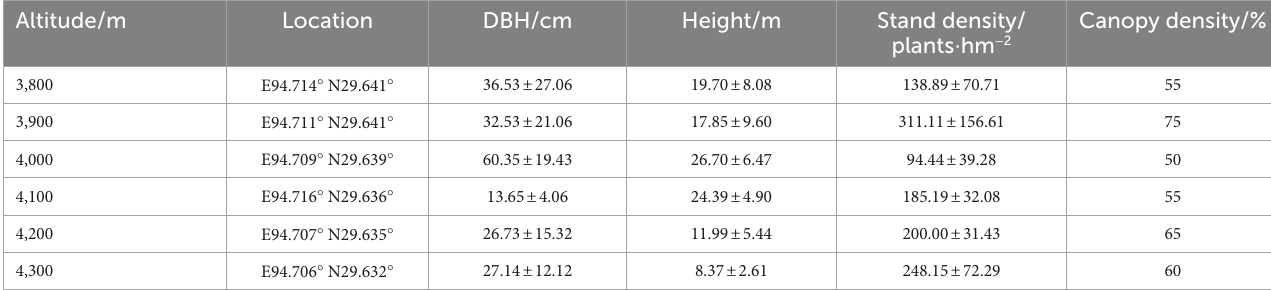
TABLE 1 Basic information of sample plots at different altitudes.